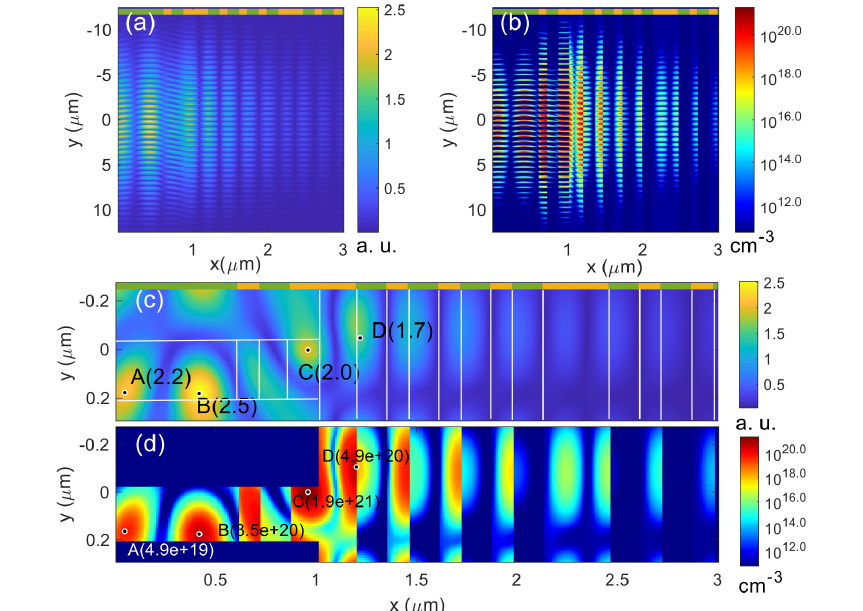
Figure 8. Simulation results of a MLD grating at 0.18 J/cm 2 . ( a ) | E | max in the grating; ( b ) Electron density in the grating; ( c , d ) are the local distributions of | E | max and electron density profiles near y = 0, respectively. The green (SiO 2 ) and yellow (HfO 2 ) indicate the materials in each layers. The high electron density is only seen in the top layers near the LID threshold, so the Ta 2 O 5 layers near the substrate are not shown. The s -polarized pulse center impinges on the grating surface at y = 0 and x = 0 from the left at AOI = 38 ◦